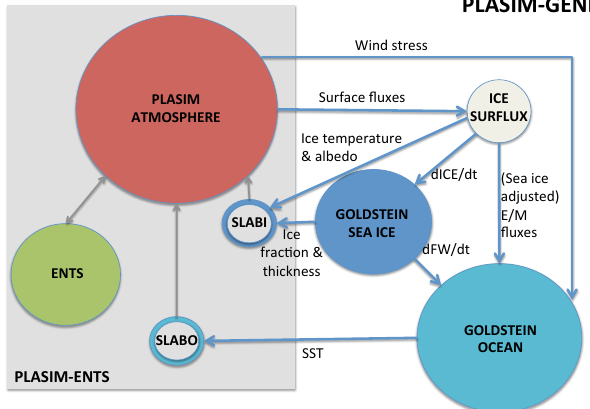
Figure 1. A schematic of the PLASIM–GENIE coupling. The circles represent the component modules, with sizes indicative of their relative complexity. The grey box defines the PLASIM– ENTS model, which has been retained in its entirety; hollow cir- cles (SLABO and SLABI) are dummy PLASIM modules, retained only to specify ocean and sea-ice boundary conditions from GOLD- STEIN outputs; grey lines are energy and moisture fluxes that are calculated within the pre-existing PLASIM–ENTS coupling. Blue arrows are variables passed in the PLASIM–GENIE coupling. ICE- SURFLUX is the new surface flux routine that was developed for the coupling (see Sect.